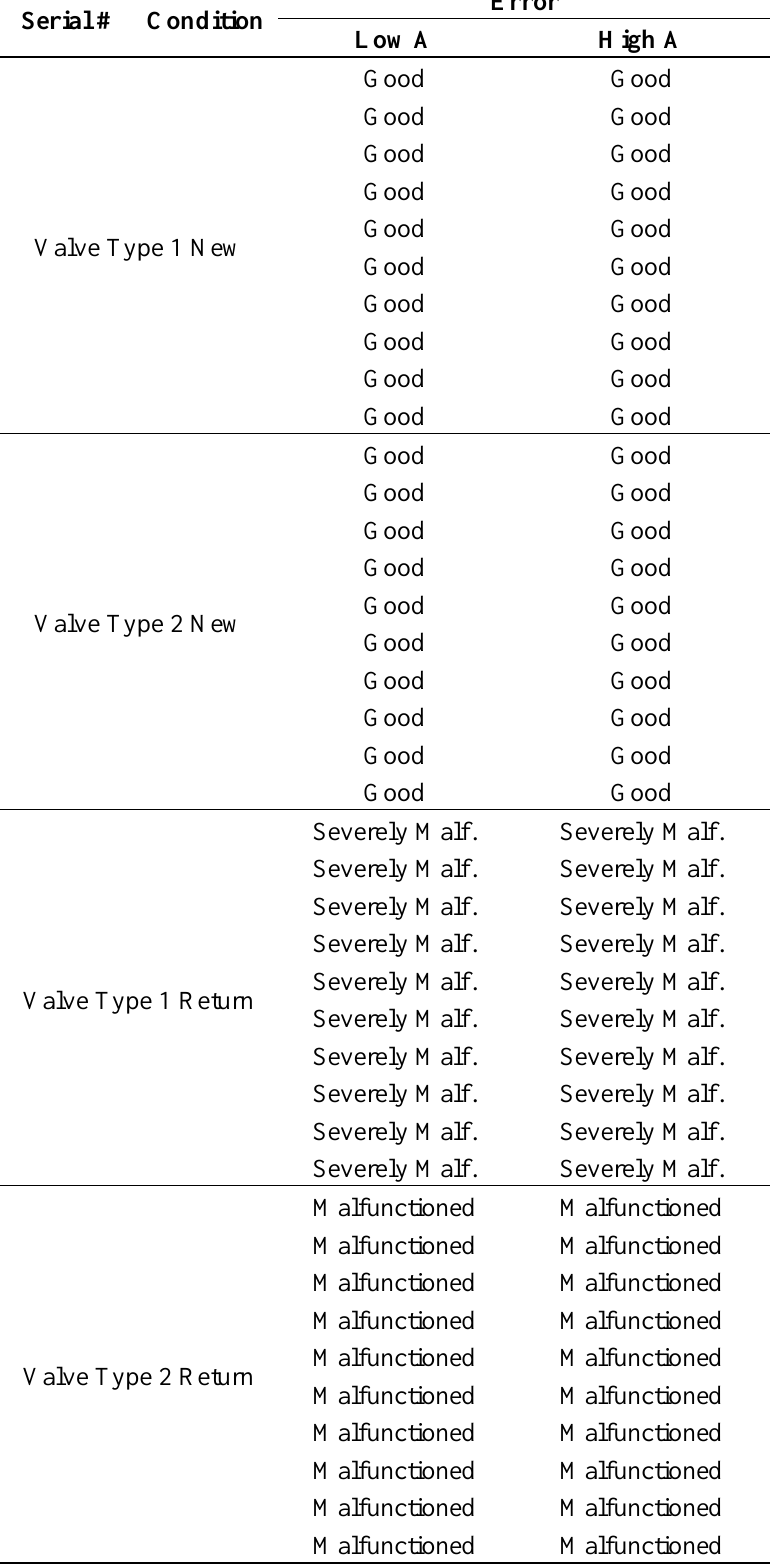
Table II. Classification of EFC Valves after fuzzy logic